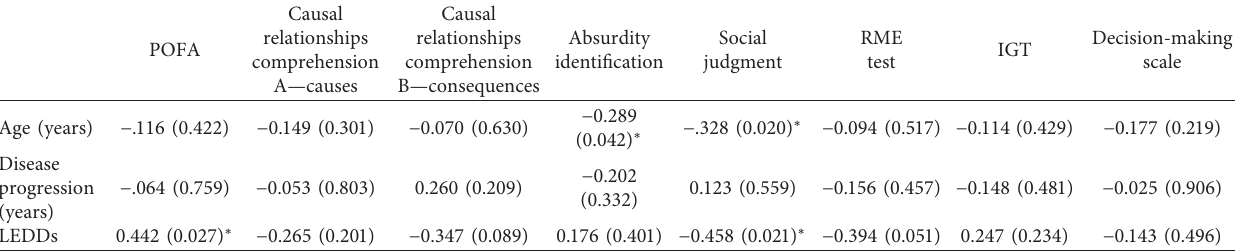
Table 4: Pearson correlations between age, years of disease progression, levodopa-equivalent daily doses, and SC variables in the EOPD group ( n �